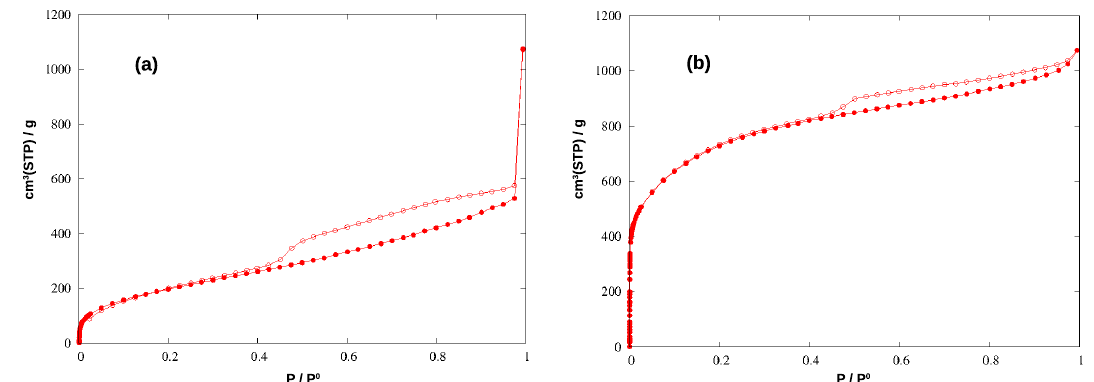
Figure 4. Adsorption (filled circles) and desorption (empty circles) isotherms of N 2 at 77 K in the hyper-crosslinked polymer ( a ) and in the carbonized material ( b ).